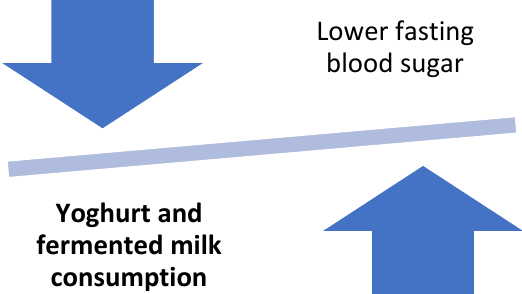
Figure 5. Effect of yoghurts and fermented milk consumption on blood sugar.